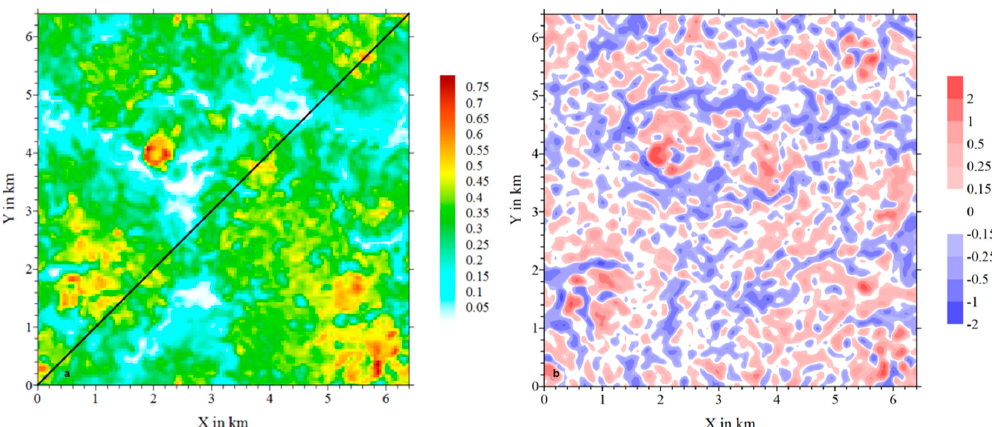
Figure 3. Horizontal cross section of ( a ) the liquid water content in g m − 3 and ( b ) the vertical wind speed in m s − 1 in the domain at 1520 m altitude after 200 min of simulation; the black line indicates the location of the vertical cross sections of Figures 4–6.